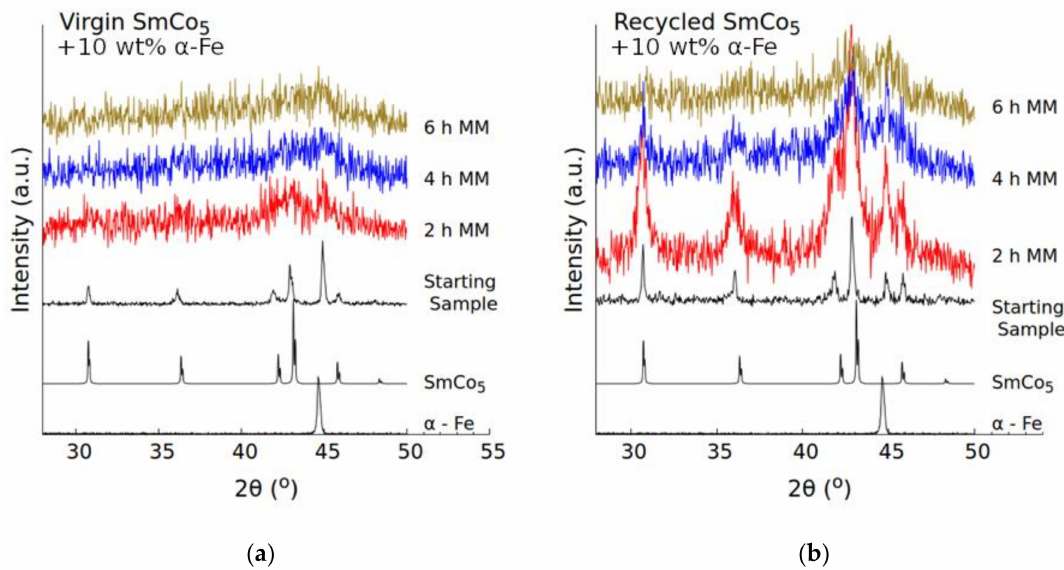
Figure 3. XRD patterns for starting mixture and as-milled (2, 4, and 6 h) virgin ( a ), and recycled materials ( b ). Primary peaks for SmCo 5 and Fe have been